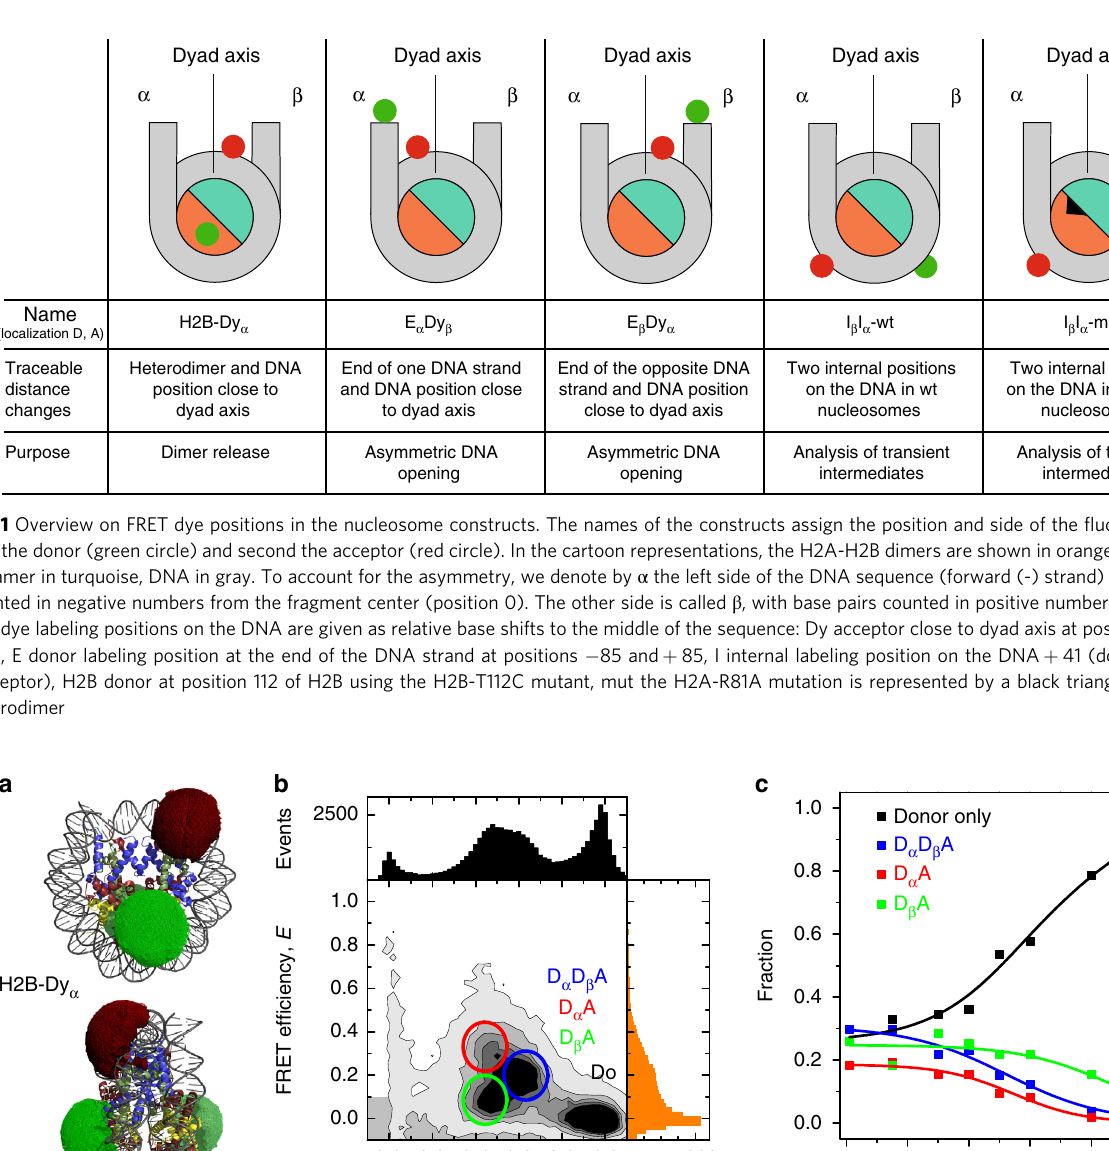
Fig. 2 MFD-PIE analysis of H2A-H2B dimer release. The nucleosome construct H2B-Dy α labeled with Alexa488 on each H2A-H2B dimer and Cy5 on the DNA was used. a Crystal structure (3LZ1) with accessible fl uorophore volumes for H2B-Dy α nucleosomes (green and red clouds for Alexa488 and Cy5, respectively) that describe the spatial distributions of the dyes. Histones are shown in blue (H3), pale green (H4), ruby (H2A), and yellow (H2B). b FRET ef fi ciency versus stoichiometry, S , for 20 pM H2B-Dy α and 980 pM unlabeled nucleosomes at 150 mM NaCl. Subspecies are identi fi ed according to their position in the 2D distribution. c Relative population of donor-only, D α A, D β A, and D α D β A for 20 pM H2B-Dy α and 980 pM unlabeled nucleosomes as a function of NaCl concentration with fi t to a sigmoid function (Supplementary Note 5, Supplementary Equation 36, global fi t with x Donor only = 1 − x − x − x fi cantly higher NaCl concentration than D α A nucleosomes, indicating that H2A-H2B heterodimers D α D β A D α A D β A ). D β A nucleosomes prevail at signi are predominantly evicted from the α -side (see details in nucleosome ends by multi-plate ensemble FRET measurements 36 (E β Dy α ) = 694 ± 12 mM). Thus, the c 1/2 values indicate that on constructs with double labeled DNA, E α Dy β and E β Dy α hexasome formation proceeds preferentially by dimer eviction from the α -side. Note that the c 1/2 values derived from species (Supplementary Methods). Labeled nucleosomes were diluted to 600 pM and incubated at different NaCl concentrations for 60 selective PIE-MFD and from ensemble measurements differ min. Both constructs behave similarly in the low-NaCl region slightly because we probed different regions and species of the (<400 mM), where reversible DNA unwrapping at both ends is nucleosome (see below and Supplementary Note 5). expected. We observe differences, though, at higher NaCl concentration where the loss of FRET indicates permanent detachment of the DNA ends from the histone core, likely Dynamic intermediates are formed with altered DNA geo- accompanied by H2A – H2B dimer eviction. The α -side was less metry . To analyze the kinetics of transient intermediates during stably bound ( c 1/2 (E α Dy β ) = 631 ± 6 mM) than the β -side ( c 1/2 disassembly we used internally labeled I β I α -wt nucleosomes with